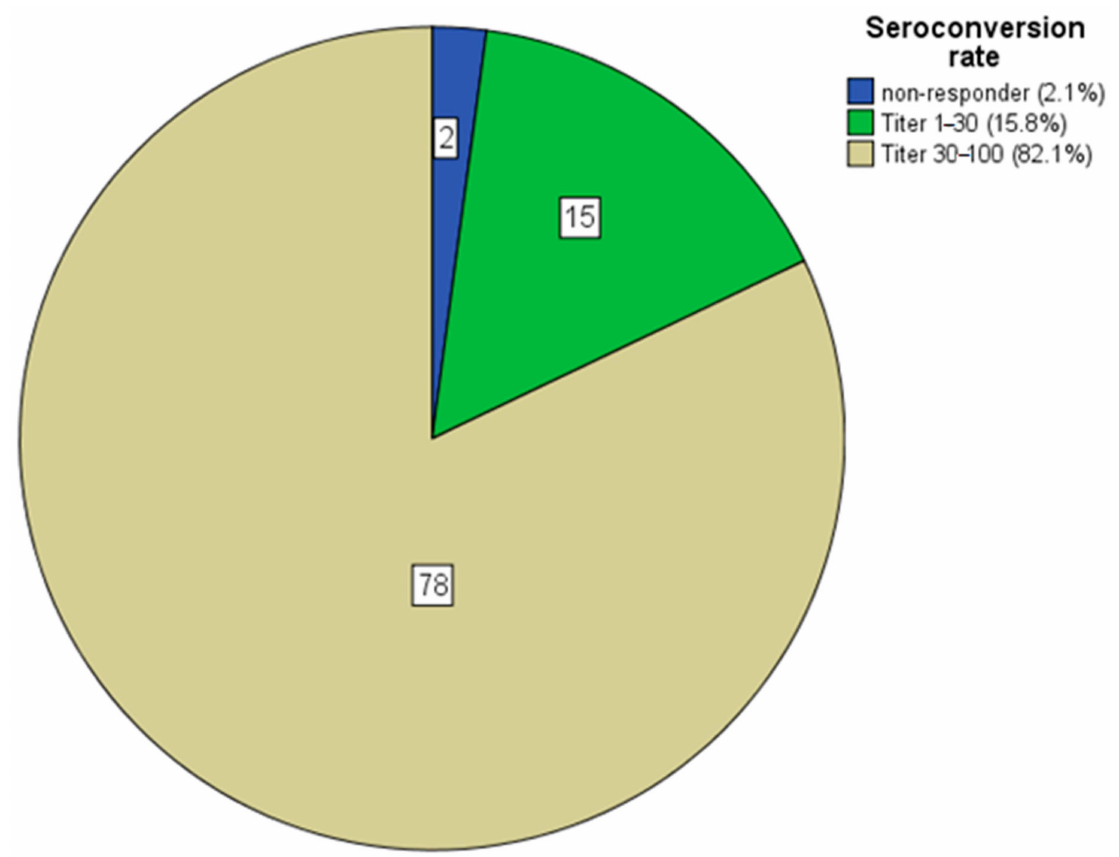
Figure 1. Seroconversion rates in numbers and percent in categories in 95 ESRD patients on hemodialysis after two doses of SARS-CoV-2 vaccination, in the control group only one person (1.7%) showed a low titer between 1 and 30 AU/mL. ESRD =